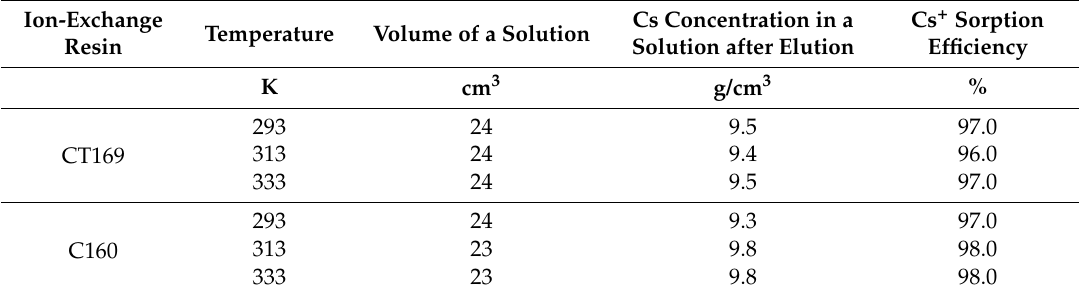
Table 4. Influence of temperature on cesium ions elution efficiency.